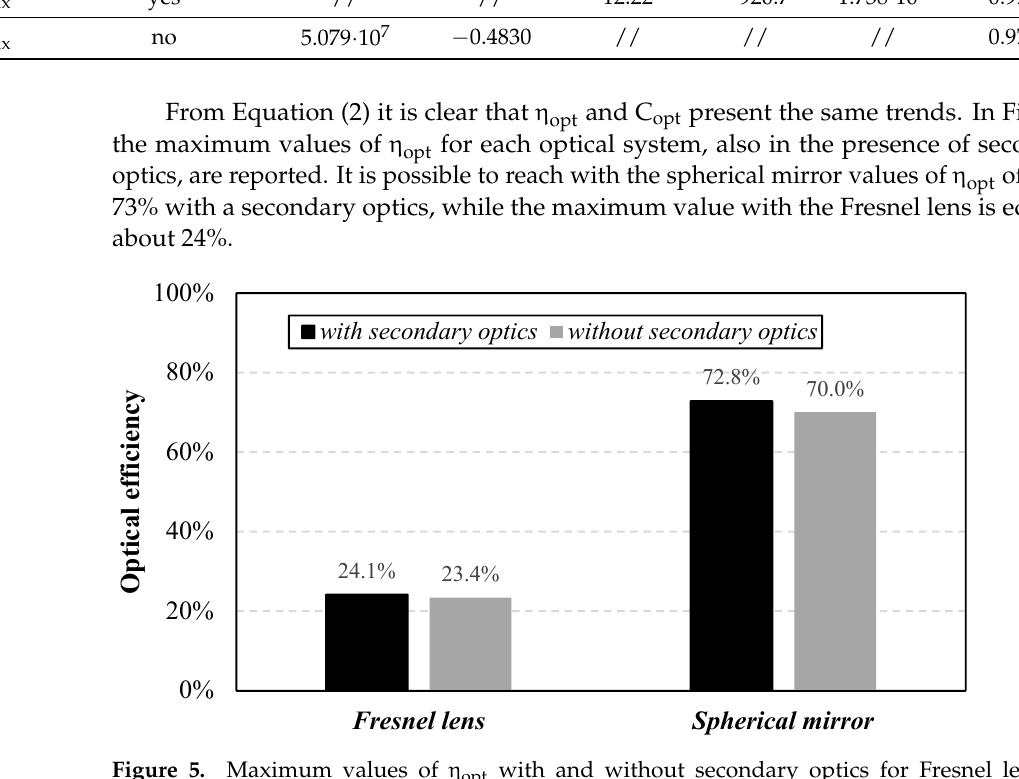
Figure 5. Maximum values of η opt with and without secondary optics for Fresnel lens and spherical mirror.